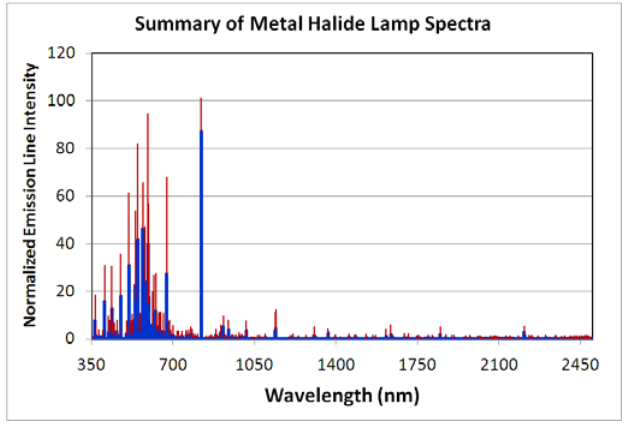
Figure 13. Spectral variability of metal halide lamps. Each of the four spectra were normalized to 1.0 and then an average (blue) and standard deviation (red) were